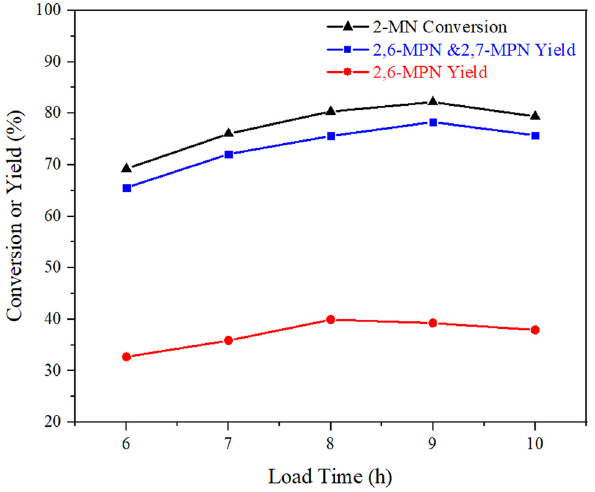
Figure 7: In fl uence ofre fl uxtime oncatalytic performance ofAlCl 3 /H β . Reaction conditions: n ( 2 - MN ) : n ( PA ) = 1:1.8, TS 10g, AlCl 3 /H β ( AlCl 3 3 g · L − 1 and calcination at 550°C for 3h ) 3 g, 190°C, 10h.